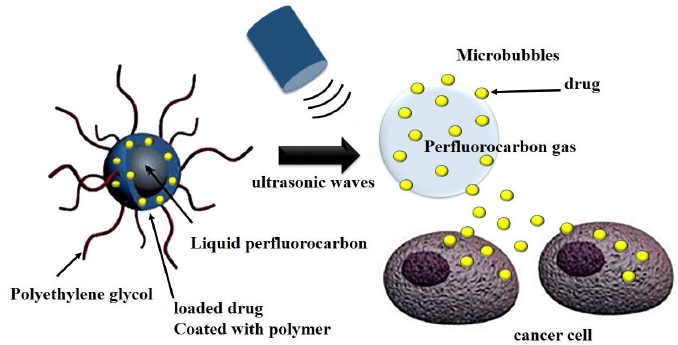
Fig. 2: Sending ultrasound waves to microbubbles and drug release in cancer tissue